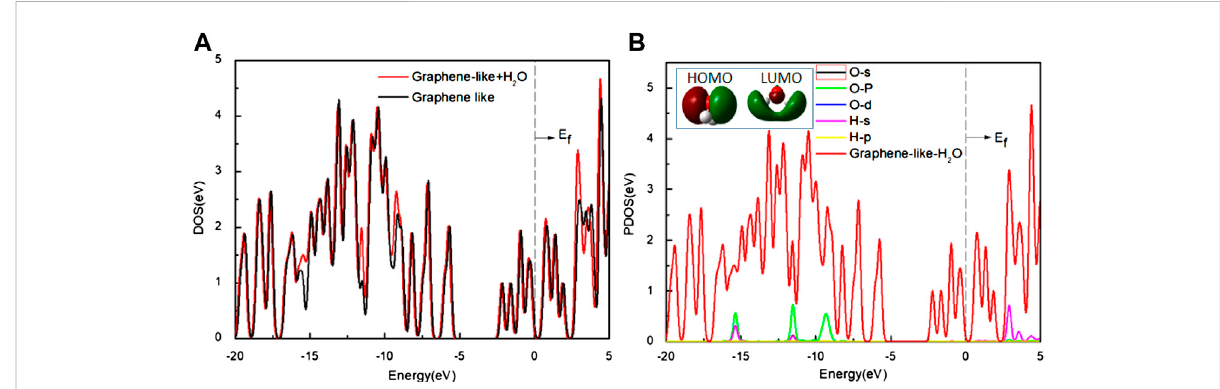
FIGURE 4 (A) The DOS of the graphene-like surface before and after adsorption of H 2 O; (B) The PDOS of H 2 O on the surface. Inset: HOMO and LUMO of H